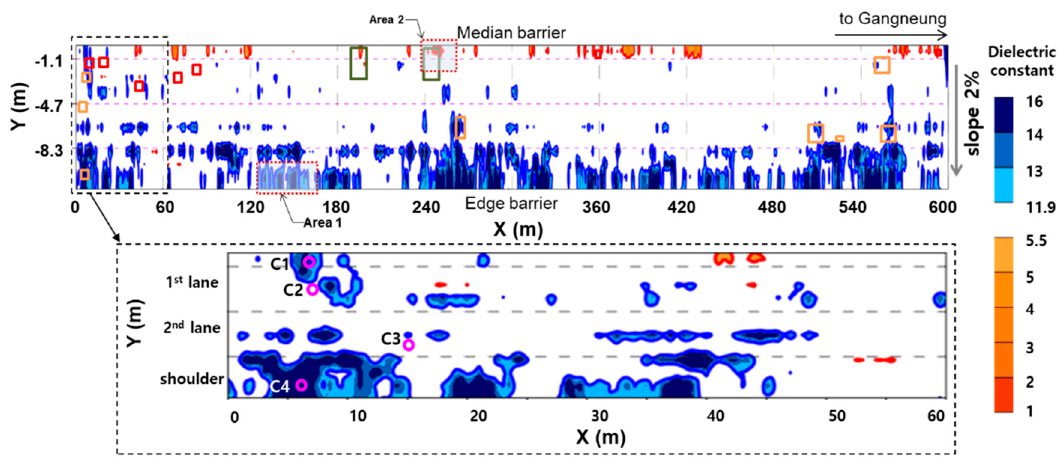
Figure 11. Plane view of dielectric constant of top concrete on the pilot target bridge deck: (red line-5.5, blue line-11.9). Surface deteriorations based on visual inspection are presented as: efflorescence, map cracking, patching).